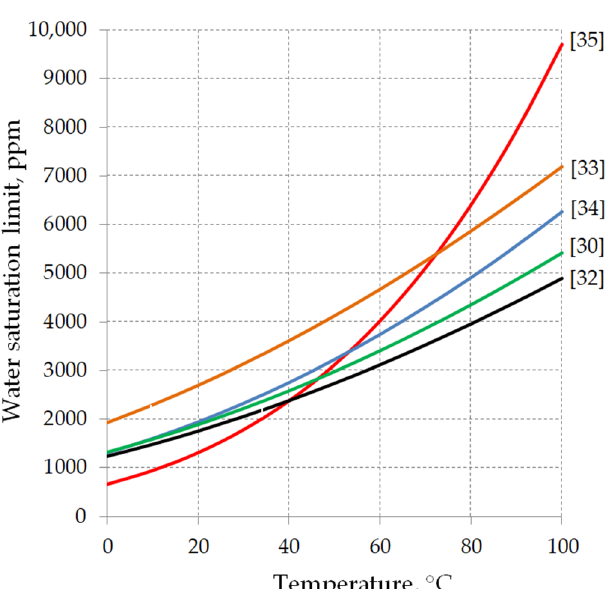
Figure 3. Water saturation limit in the function of temperature for synthetic ester Midel 7131 determined on the basis of water saturation coefficients taken from [30,32–35].